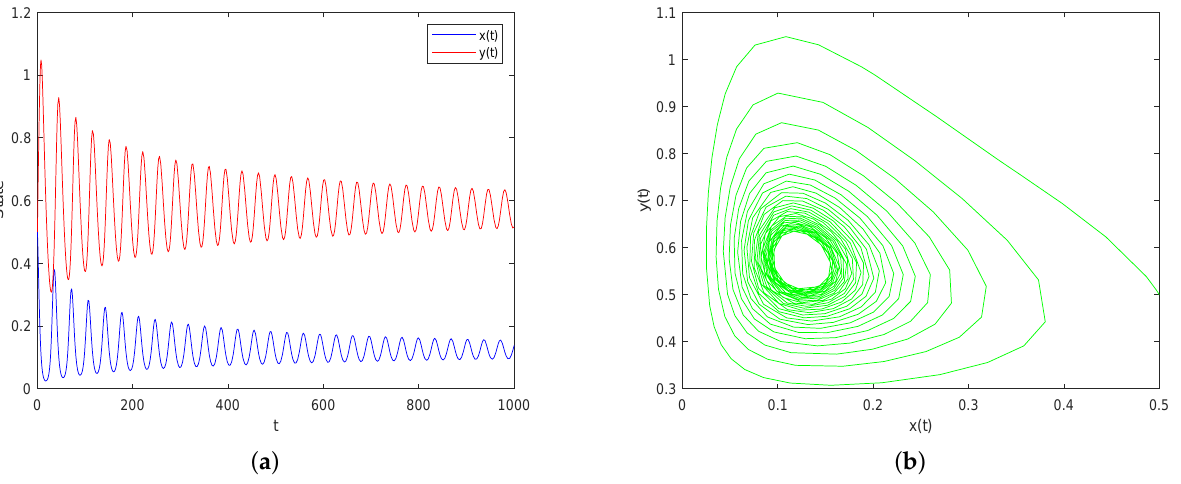
Figure 6. ( a ) Time series and ( b ) phase portrait of E ∗ for system (1) when τ 2 = 2.5 and τ 1 = 0. Other parameters are the same as in (32).